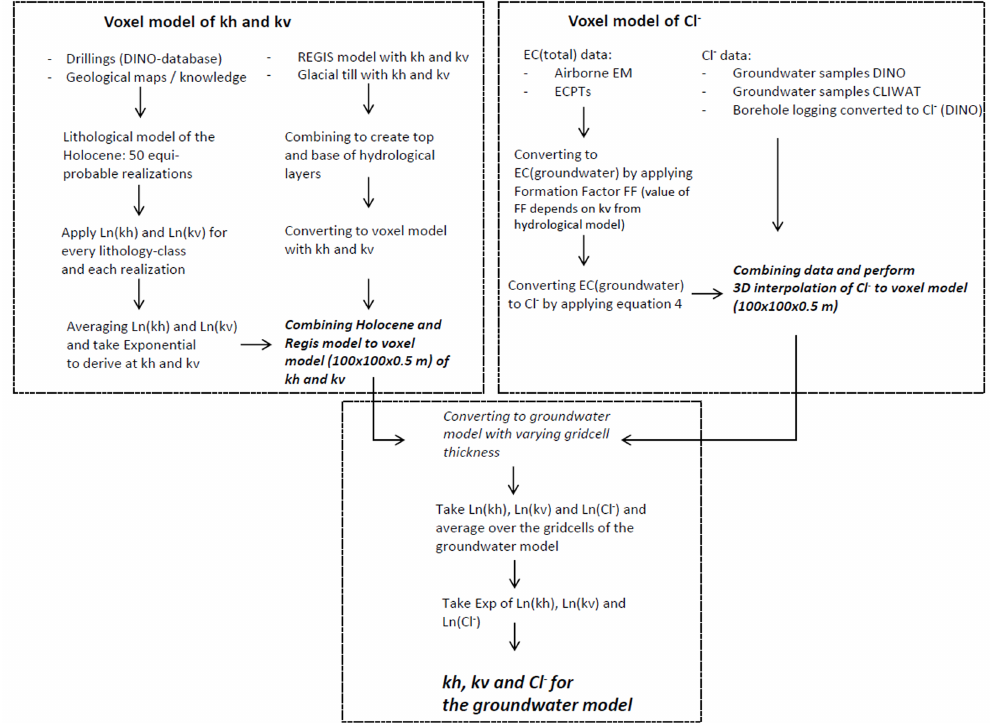
Figure 10 3-D chloride distribution field in the study area obtained after the interpolation of the measurements.